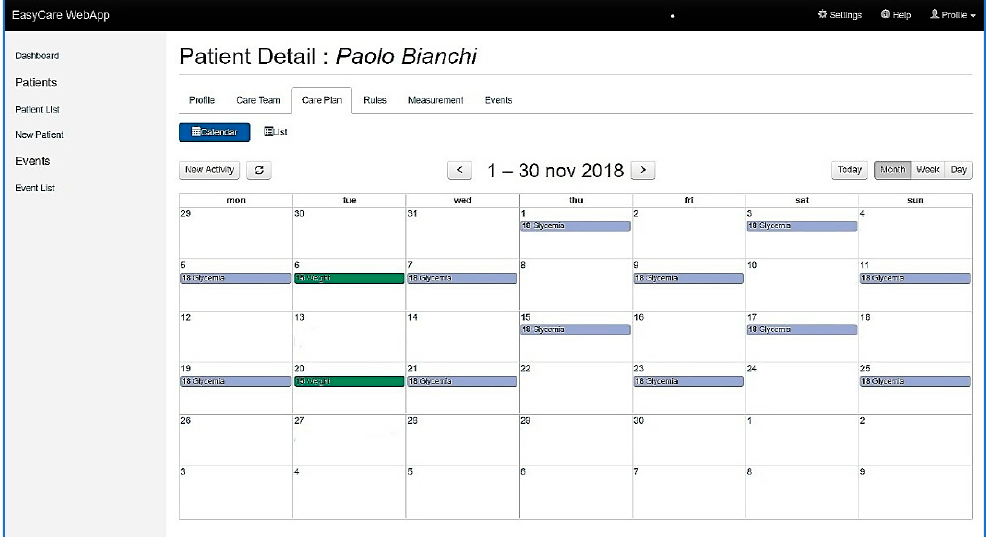
Figure 7. Patient-specific care plan management page.